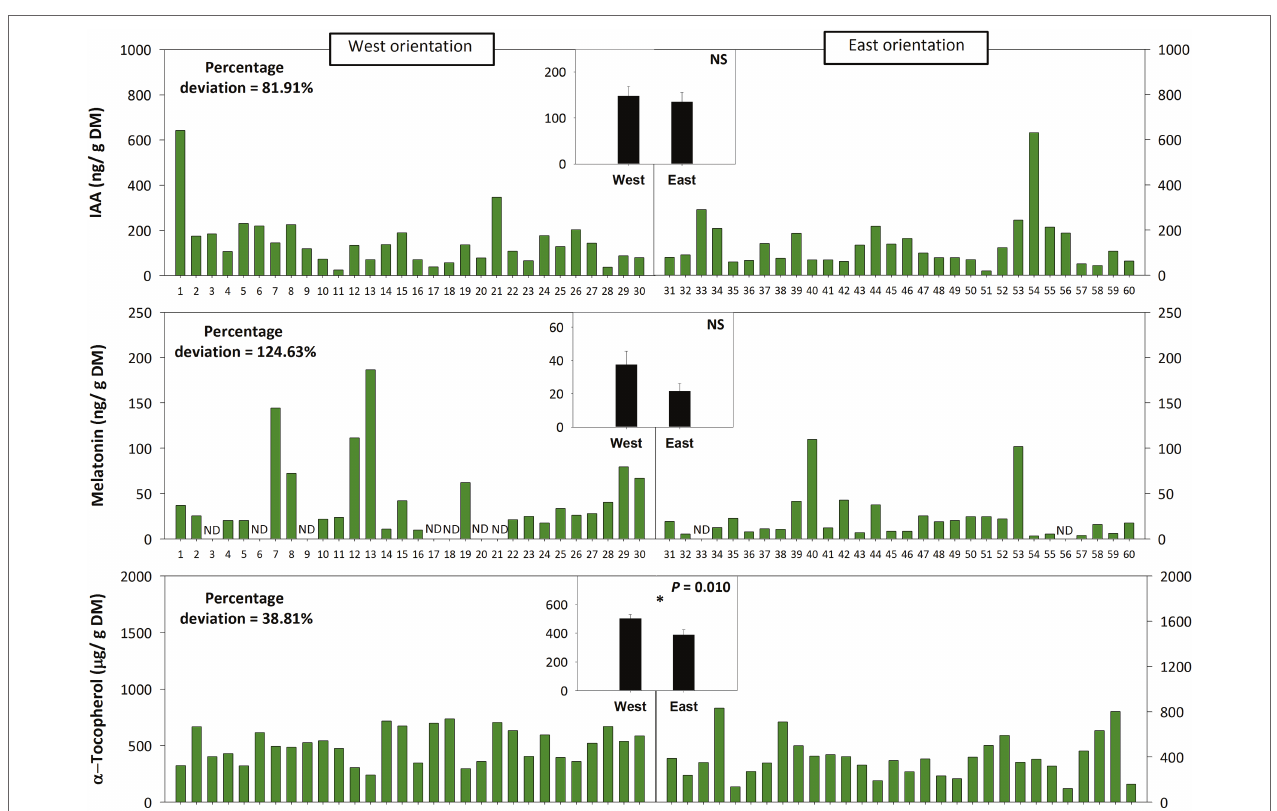
FIGURE 6 | Effects of sun orientation and inter-individual variability on endogenous melatonin contents in the Mediterranean shrub, C. albidus . A comparison of melatonin contents relative to those of the biosynthesis-related phytohormone auxin and the well-known chloroplastic antioxidant α -tocopherol in a C. albidus population growing at 1,100 m.a.s.l. in the Natural Park of the Montserrat Mountains with different sun orientation (East orientation, n = 30 individuals, West orientation, n = 30 individuals) during winter (22nd March 2018) is shown. Data correspond to leaf position 2 from the apex (see photograph in Figure 3 for details) for all studied individuals. The number of the individual (ordered from lower to higher leaf angle) is indicated in the x-axis. Percent deviation for every variable is given as (SD/population mean) × 100, where SD corresponds to standard deviation. The mean ± SE for each sun orientation is shown in the graphs located in the inlets. Significant differences between groups were tested by a one-way analysis of variance (ANOVA, p ≤ 0.05) and indicated with an asterisk. NS, not significant; DM, dry